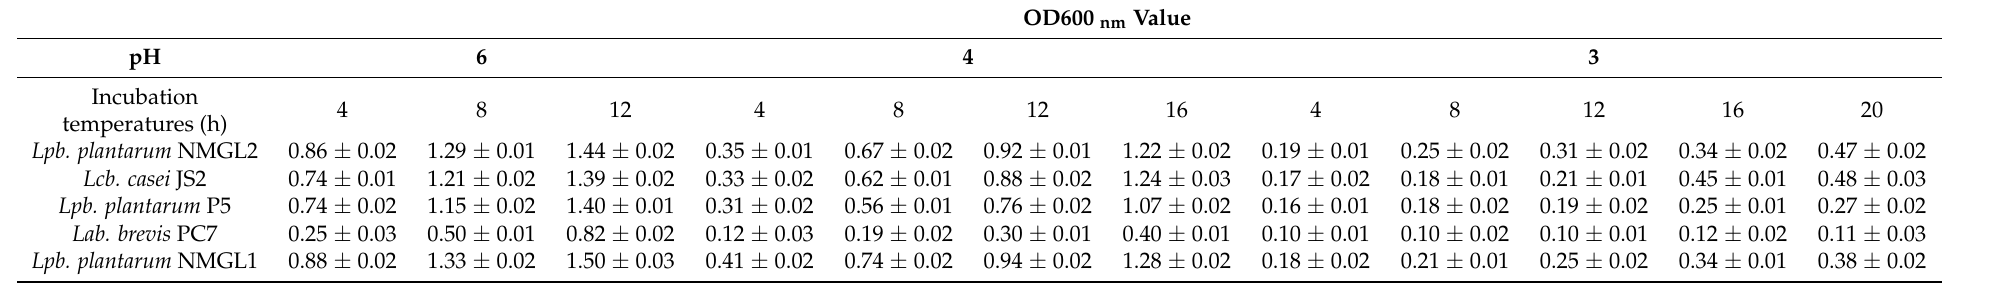
Table 2. Growth of 5 strains of lactic acid bacteria at pH 6.0, 4.0, and 3.0 ( n = 3, x ±